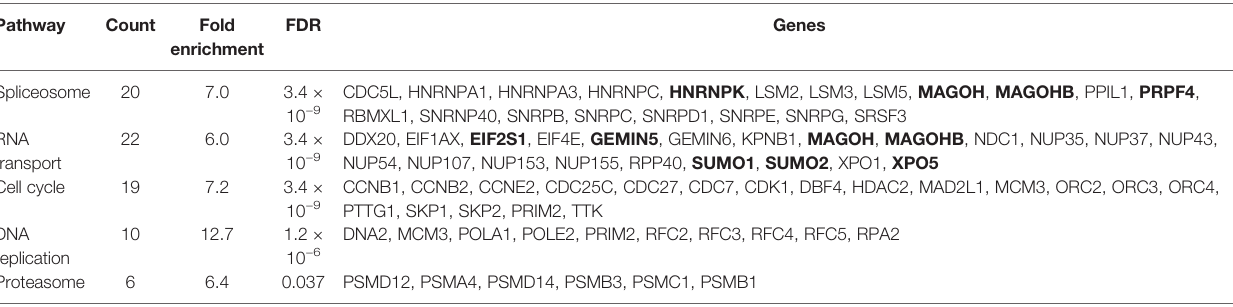
TABLE 5 | Pathway enrichment of gene expression correlating positively with glyoxalase 1 expression in tumor cell lines of the CCLE. Pathway Count Fold FDR Genes enrichment